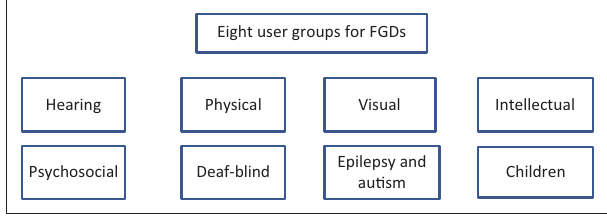
FIGURE 1: Sampling framework for focus group